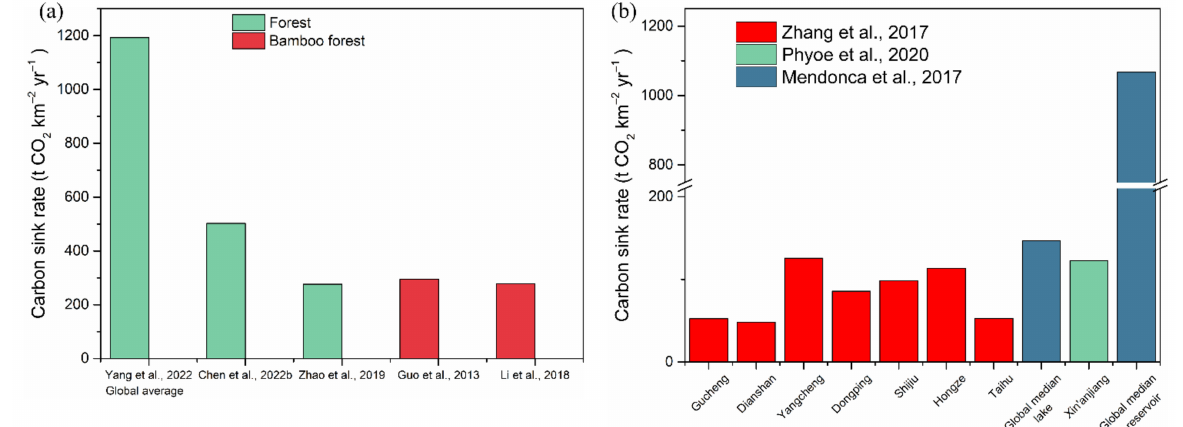
Figure 2. Carbon sink rates in terrestrial ecosystems from different studies. ( a ) Forest and bamboo forest; ( b ) lakes and reservoirs. Source of data: Yang et al., 2022, global average forest carbon sink rate [13], for comparison, not used in the final forest carbon sequestration rate range in Zhejiang Province; Chen et al., 2022b, the growth rate of natural-forest carbon density in the pre-mature and mature stage [8]; Zhao et al., 2019, total forest biomass carbon stocks in Zhejiang Province in different years [12]; Guo et al., 2013, total bamboo forest biomass carbon stocks in Zhejiang Province in different years [14]; Li et al., 2018, total bamboo forest aboveground biomass carbon stocks in Zhejiang Province in different years [15]; Zhang et al., 2017, 7 lakes from Jiangsu, Shanghai [16]; Phyoe et al., 2020, Xin’anjiang Reservoir from Zhejiang Province [17]; Mendonca et al., 2017, the median global carbon sink rates of lakes and reservoirs